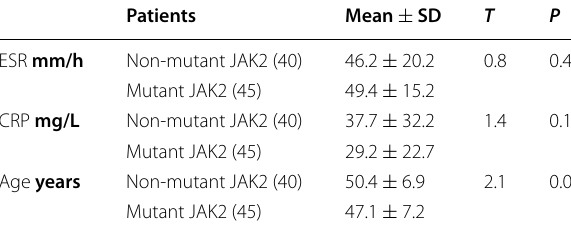
% in rows Table 4 Age, ESR, and CRP levels in patients groups Patients